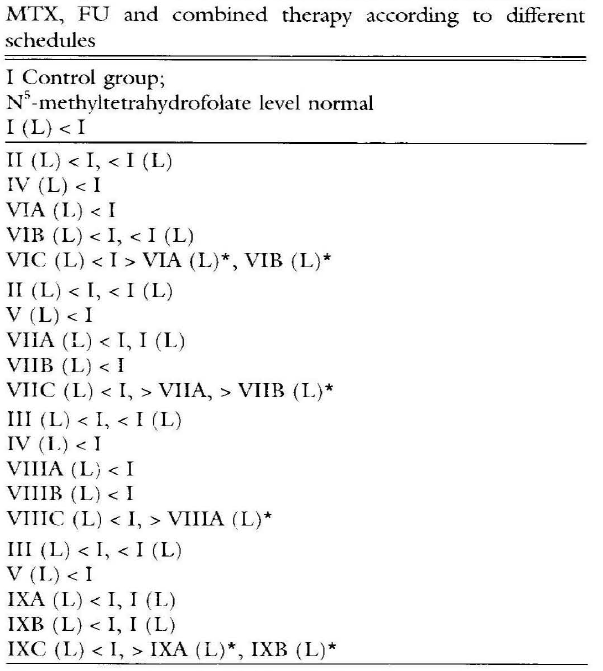
Table 14. Statistically significant difterences in N"-methyl tetrahydrofolate levels in erythrocytes between the groups of RD!', mice with L1210 leukemia after administration of MTX, FU and combined therapy according to different schedules